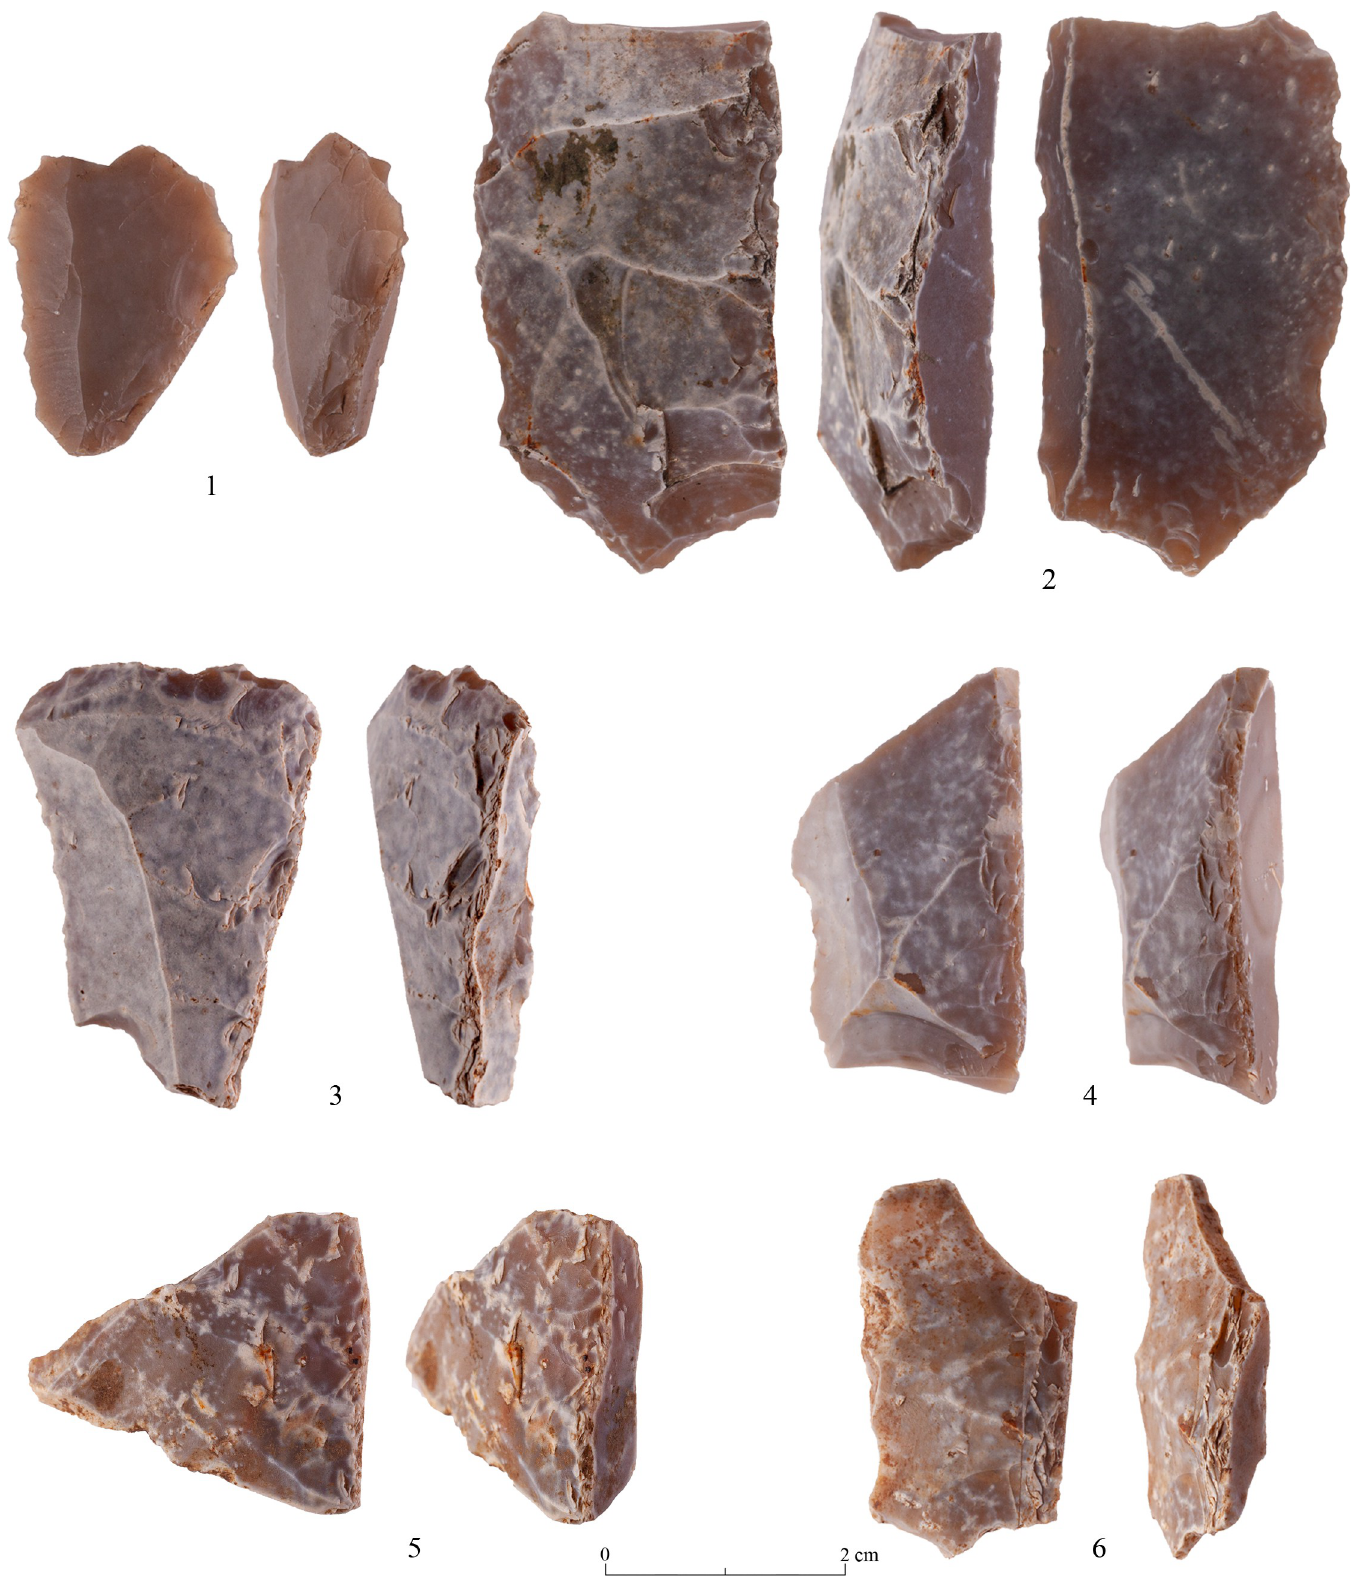
Fig 42. Lateral biface